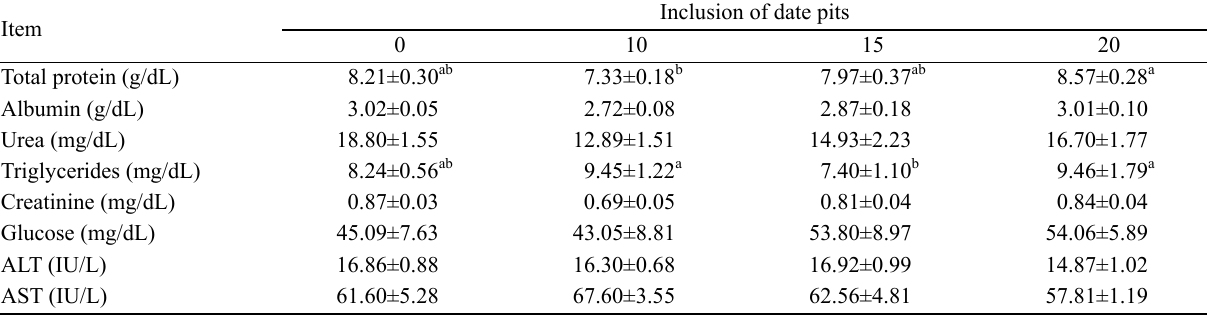
Table 4. Serum biochemical values of Ardi lactating goats